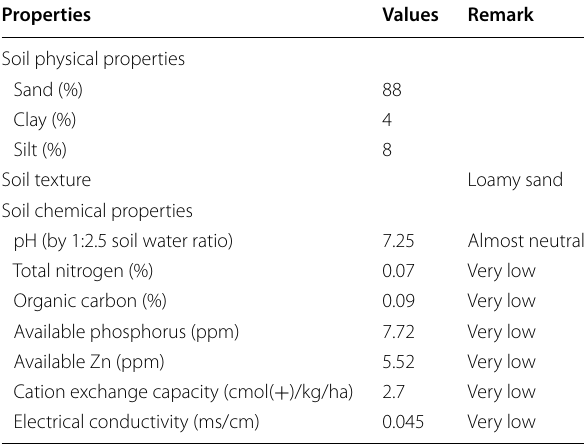
Table 2 Some Physicochemical properties of the soil